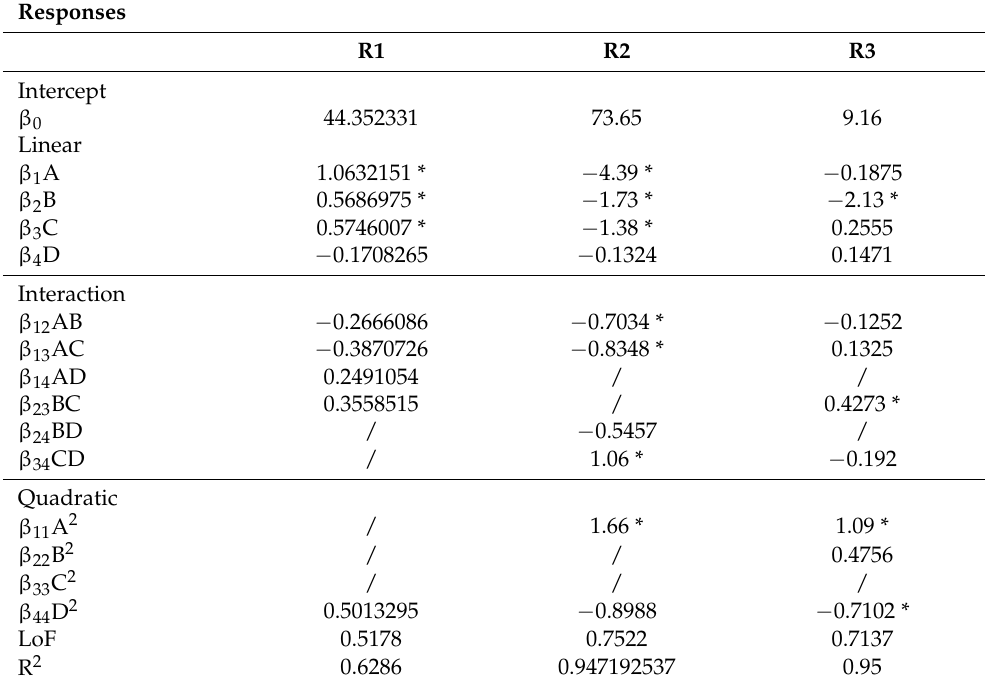
Table 4. Second-order polynomial equations for targeted responses.